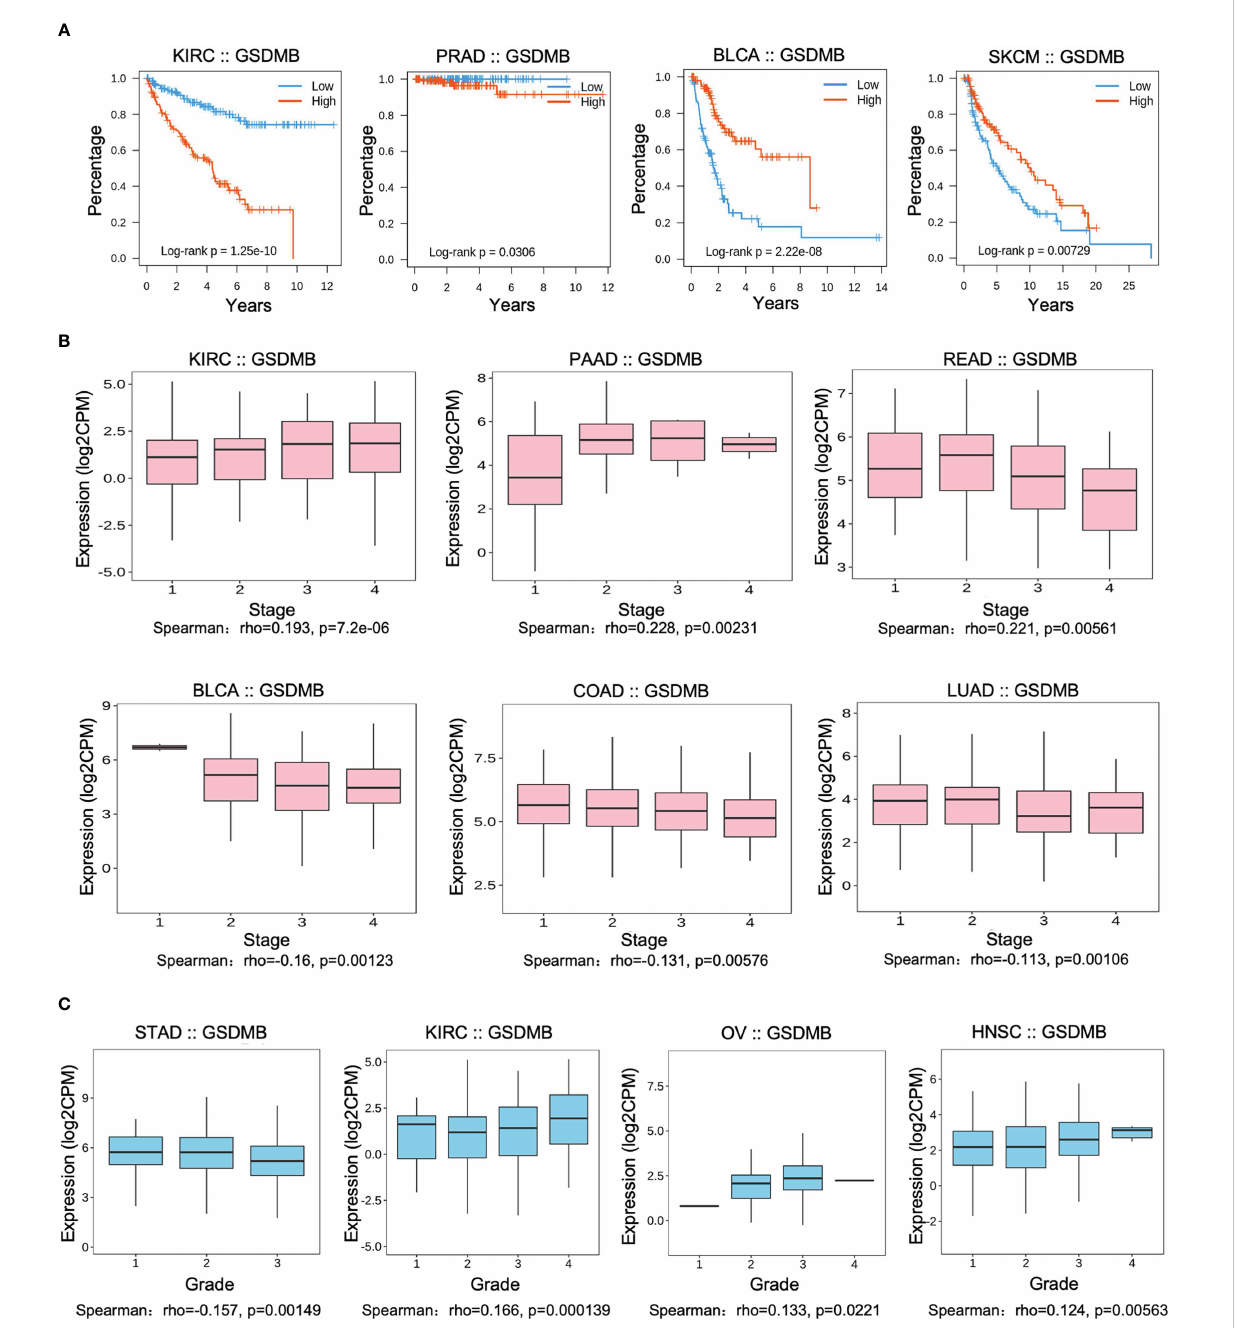
FIGURE 1 Associations between GSDMB and clinical features. (A) Associations between GSDMB expression and overall survival across human cancers. Kaplan – Meier survival curves for GSDMB gene expression were associated with overall survival. Patients were divided into high- and low-expression groups de fi ned by the expression level of GSDMB gene (median was the cutoff). (B) Associations between GSDMB expression and stage across human cancers. Spearman ’ s correlation coef fi cient (rho) for GSDMB gene expression is positive in KIRC, PAAD, and rectal carcinoma (READ). Spearman ’ s correlation coef fi cient (rho) for GSDMB gene expression is negative in BLCA, COAD, and LUAD. (C) Associations between GSDMB expression and grade across human cancers. Spearman ’ s correlation coef fi cient (rho) for GSDMB gene expression is positive in KIRC, OV, and HNSC and negative in STAD. Spearman ’ s rank correlation rho represents the direction of association between X (independent variable) and Y (dependent variable). The magnitude of Spearman ’ s correlation increases as X and Y become closer to a perfect monotonic function of each other. When X and Y are entirely monotonically correlated, Spearman ’ s correlation coef fi cient becomes 1. GSDMB, gasdermin B; KIRC, kidney renal clear cell carcinoma; PAAD, pancreatic adenocarcinoma; READ, rectal carcinoma; BLCA, bladder urothelial carcinoma; COAD, colon adenocarcinoma; LUAD, lung adenocarcinoma; KIRC, kidney renal clear cell carcinoma; OV, ovarian serous cystadenocarcinoma; HNSC, head and neck squamous cell carcinoma; STAD, stomach